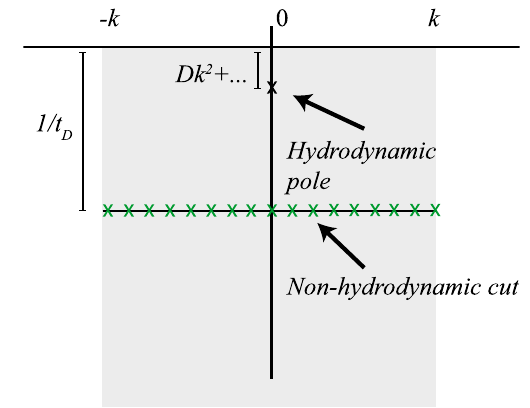
Fig. 4 Analytic structure of the retarded shear correlation function (ω, k ) in the complex frequency plane for the kinetic theory with G 0 x , 0 x R scale-independent relaxation time